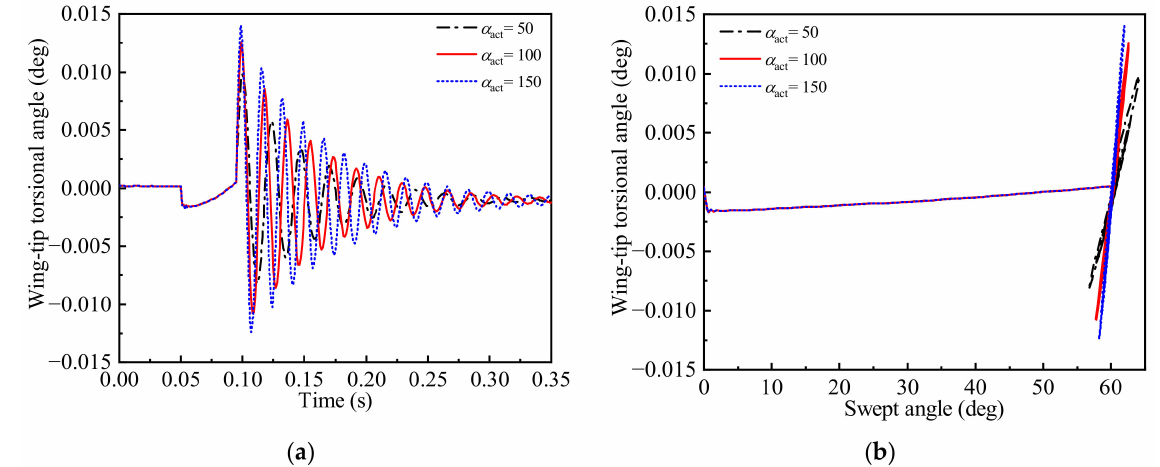
Figure 24. Transient responses of the wing-tip torsional angle. ( a ) Torsional angle vs. time. ( b ) Torsional angle vs. sweep angle.